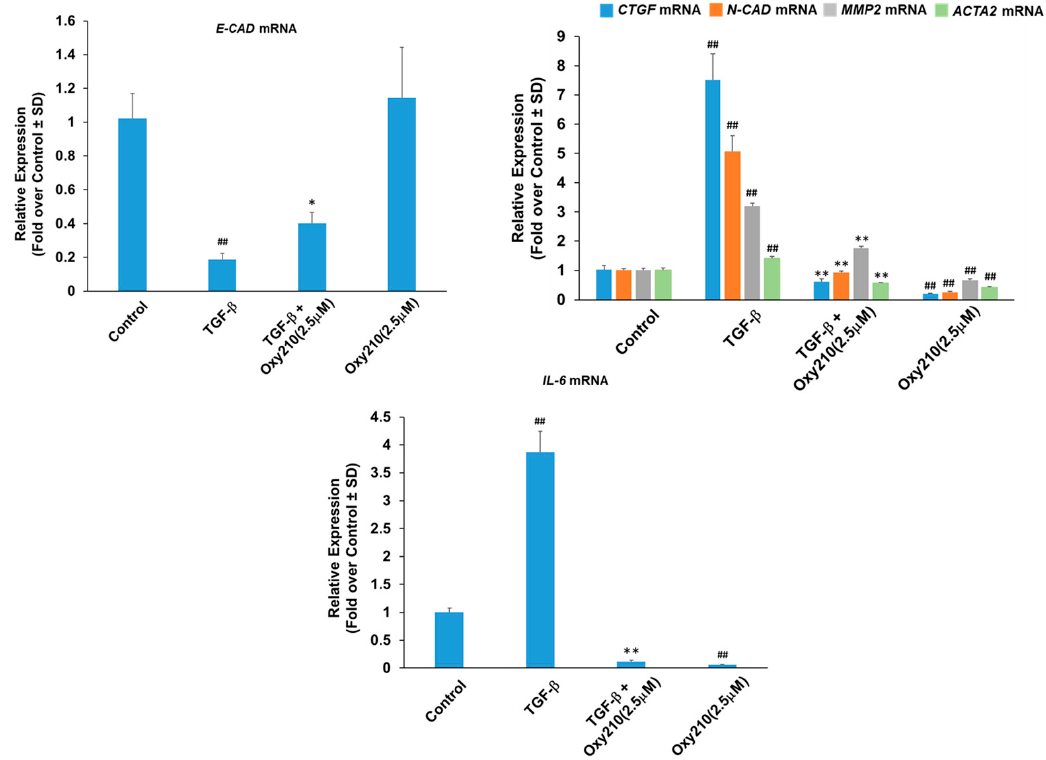
Figure 4. Oxy210 inhibits the expression of TGF- β target genes in HSAE cells including EMT genes and the inflammatory cytokine, IL-6 . HSAE cells were pretreated with Oxy210 in DMEM containing 1% FBS for 4 h and then treated with TGF- β 1 (10 ng/mL) in the absence or presence of Oxy210. After 72 h, RNA was analyzed by Q-RT-PCR for gene expression and normalized to GAPDH . Data from a representative experiment are reported as the mean of triplicate determinations ± SD (## p < 0.01 vs. control; * p < 0.05 vs. TGF- β ; ** p < 0.01 vs. TGF- β ).